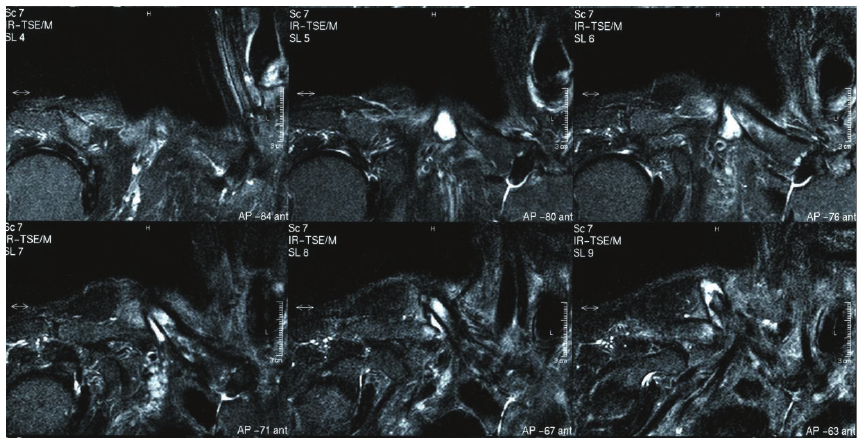
Figure 3: Preoperative MRI STIR images demonstrating a formation of pseudoarthrosis with fluid collection and suggesting bone marrow edema at both ends of the fracture fragments.